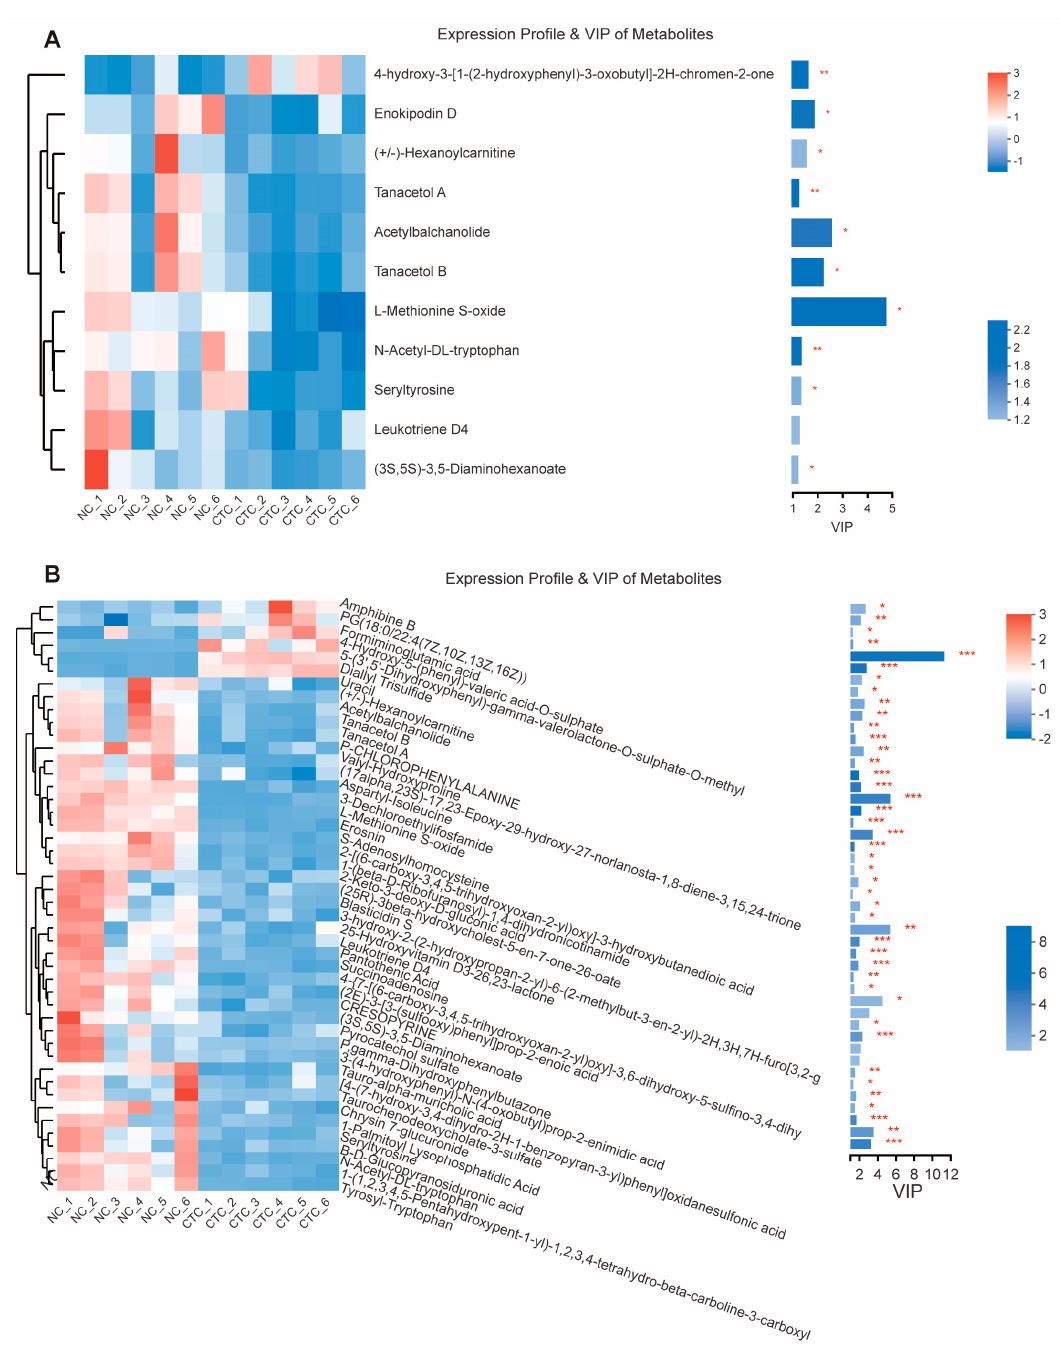
Figure 7. Panels ( A ) and ( B ) show the relative abundance of differential metabolites and their VIP values for dietary supplementation of CTC and EM, compared with the NC group. * p < 0.05, ** p < 0.01, *** p < 0.001. N = 6 per treatment group.